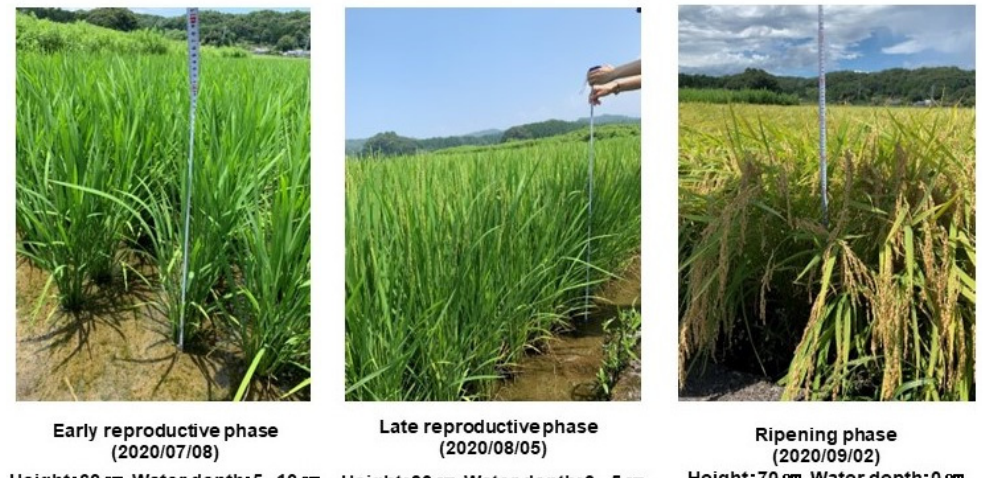
Figure 2. Rice paddy growth phase.